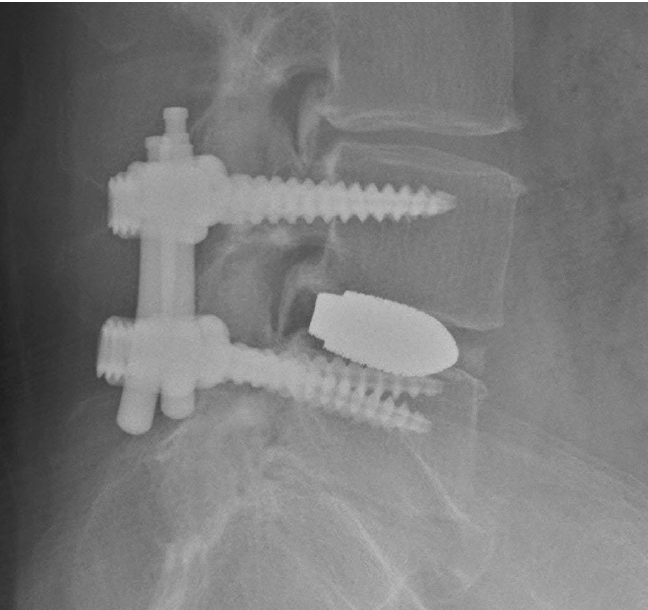
Figure 8. Lateral radiograph of ossification of the posterior longitudinal ligament of the lumbar